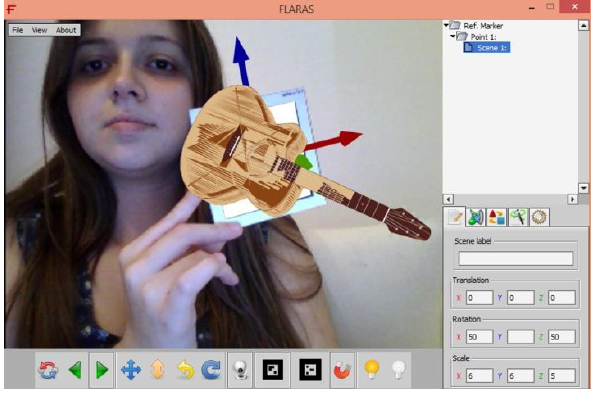
Figure 1. Operation of Augmented Reality